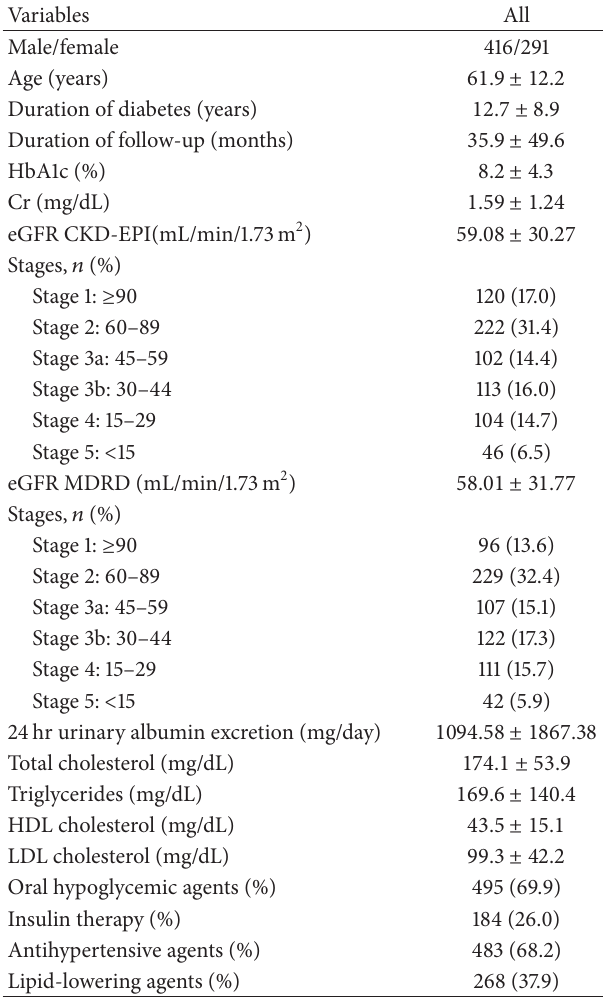
Table 1: Demographic and baseline characteristics of the partici- pants ( 𝑛 = 707